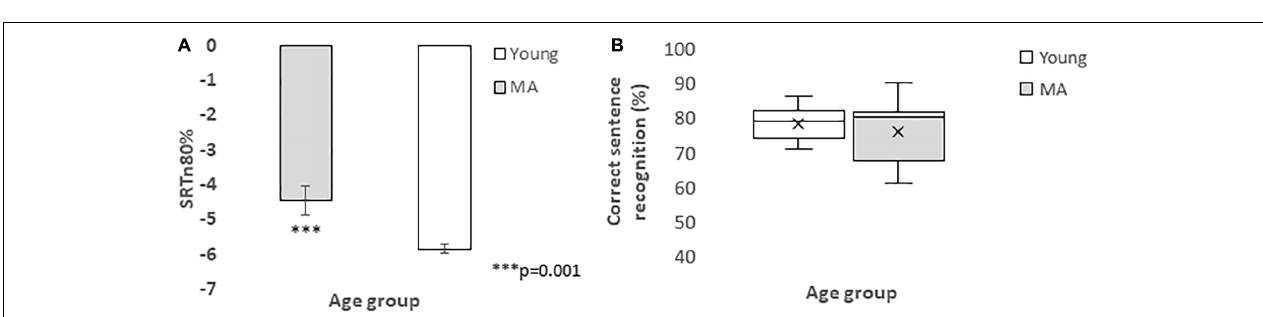
FIGURE 1 | Mean ( ± sd) air conduction thresholds for the young and middle-aged groups.